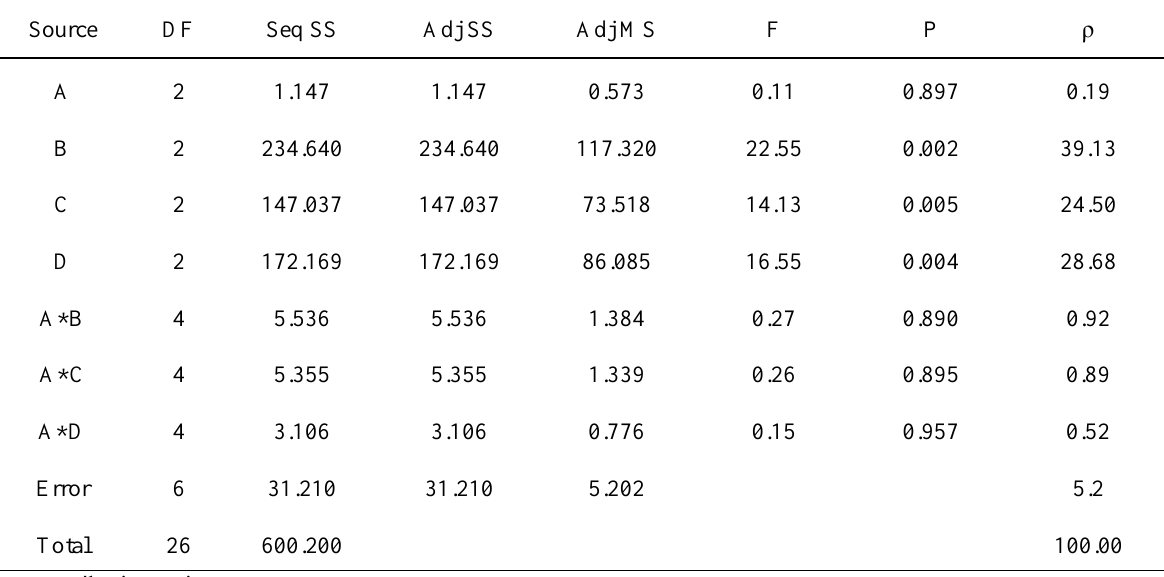
Table 5. ANOVA for the response of operating costs (US$/m 3 ) in Taguchi method.